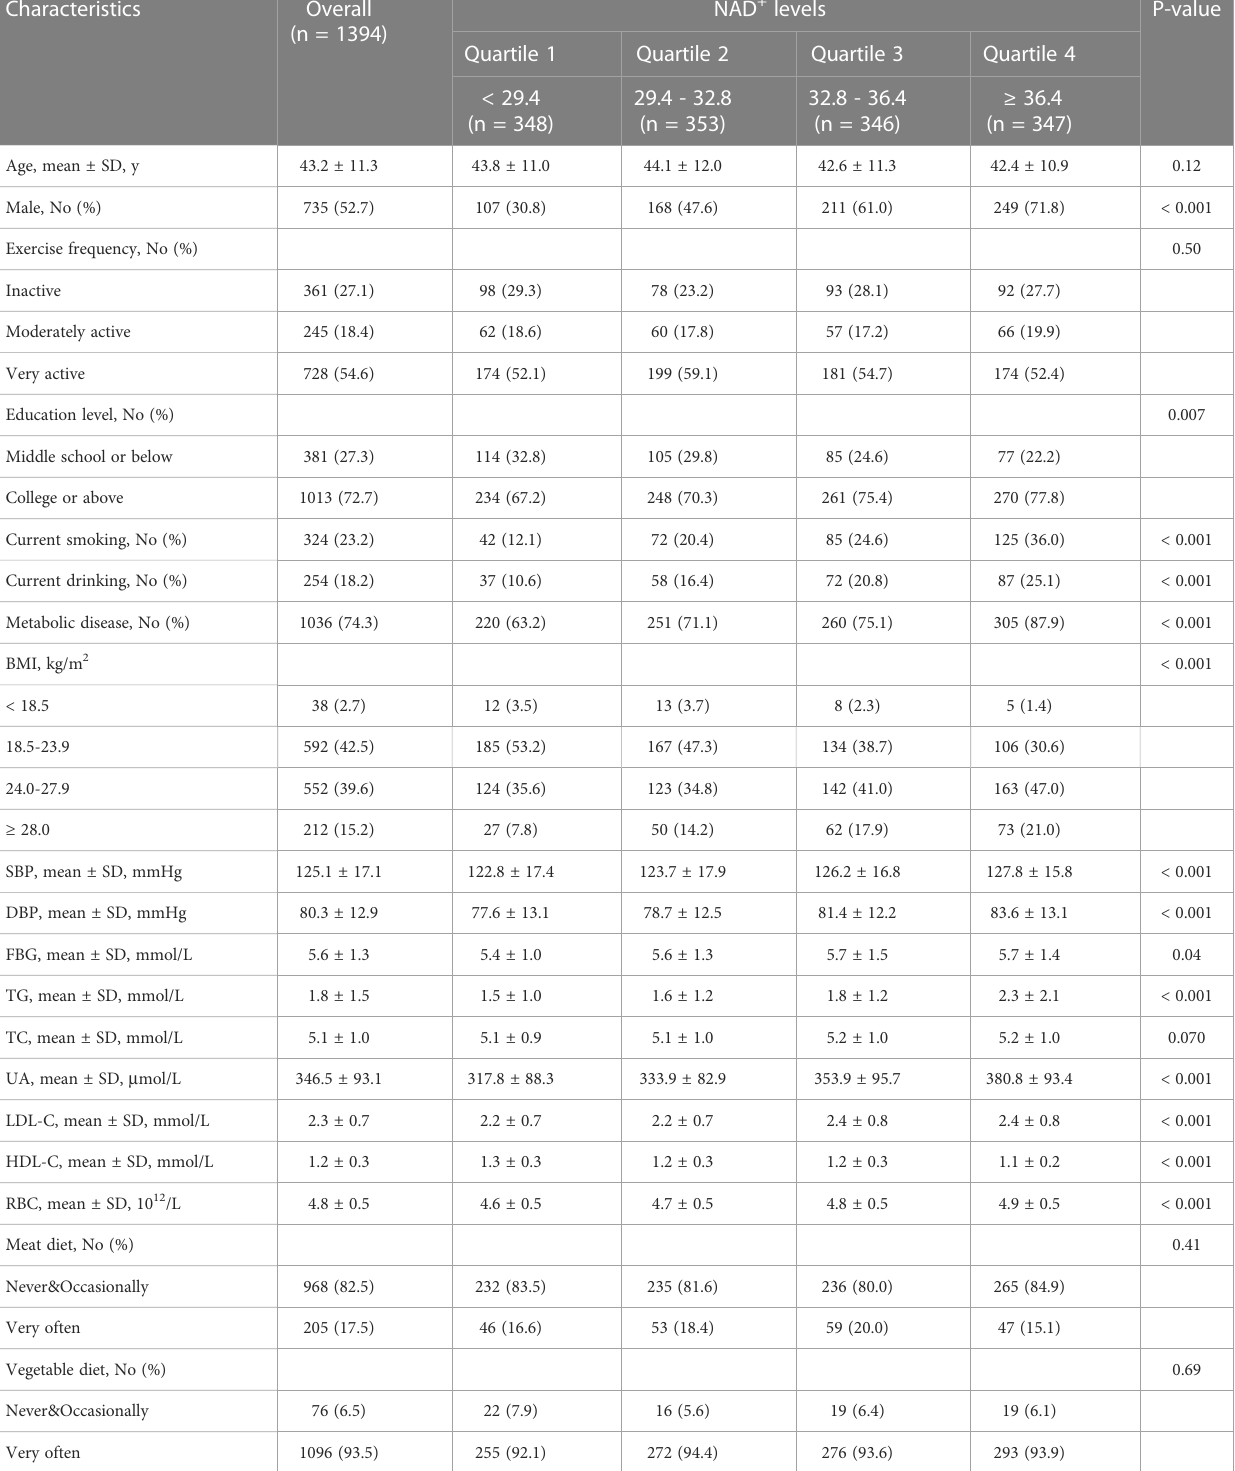
TABLE 1 Baseline characteristics of eligible participants according to NAD + levels in the study.